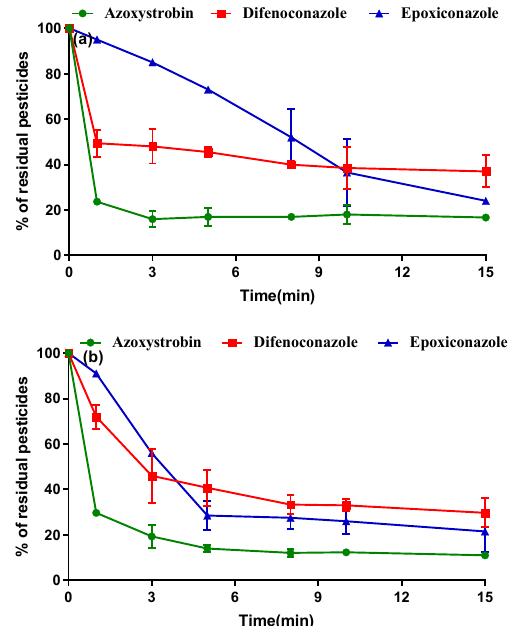
Figure 2. Effects of boiling on the residue levels of three pesticides in Paeoniae Radix Alba (PRA) after soaking at two pesticide concentrations: two times ( a ) and five times ( b ) the recommended dosage.